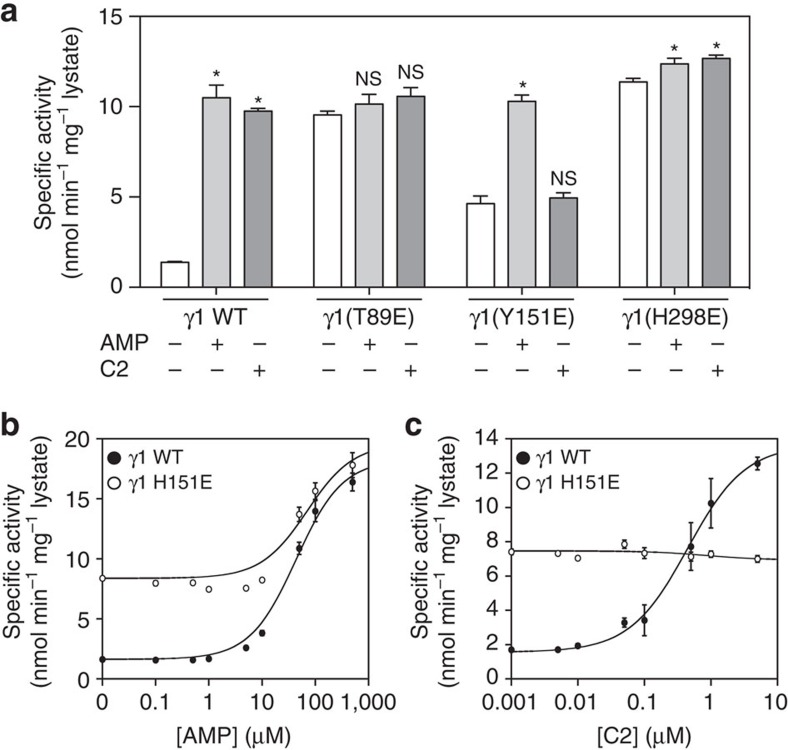
Effect of AMPK γ-subunit mutations on C2 activity.AMPK α1β1γ1 phospho-mimetic T172D and their respective γ mutants T89E, H151E, and H298E were expressed as FLAG-α fusion proteins in COS7 mammalian cells. (a) Activities of AMPK mutants were tested in the absence or presence of C2 (5 μM) or AMP (100 μM). Results from four independent experiments are presented as specific activity (nmol min−1 mg−1 lysate±s.e.m.), with statistical tests conducted using one-way ANOVA. *P<0.05 indicates significant increase in activity compared with untreated control. (b) AMP dose–response of AMPK α1-T172D γ1 wild-type and γ1-H151E mutants (0–500 μM). The data was plotted as AMPK activity (nmol min−1 mg−1 lysate±s.e.m.) versus [AMP] (μM) from four independent experiments. (c) C2 dose–response of AMPK α1-T172D γ1 wild-type and γ1-H151E mutants (0–5 μM). Curve was plotted as AMPK activity (nmol min−1 mg−1 lysate±s.e.m.) versus [C2] (μM) from four independent experiments. The values for EC50 and fold stimulation were calculated based on fitting the data to the equation: Activity=Basal+(((Fold stimulation × Basal)−Basal × [C2])/((EC50)+[C2])).